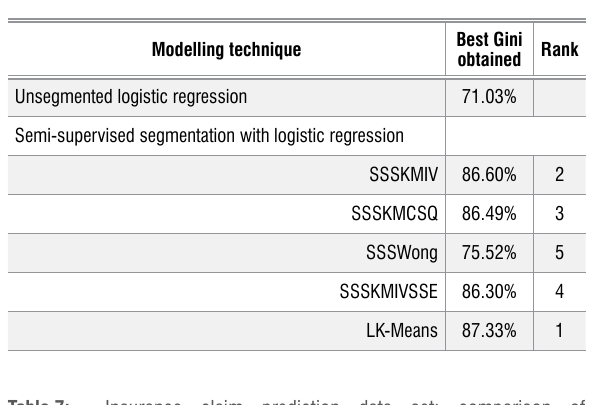
Insurance claim prediction data set: comparison